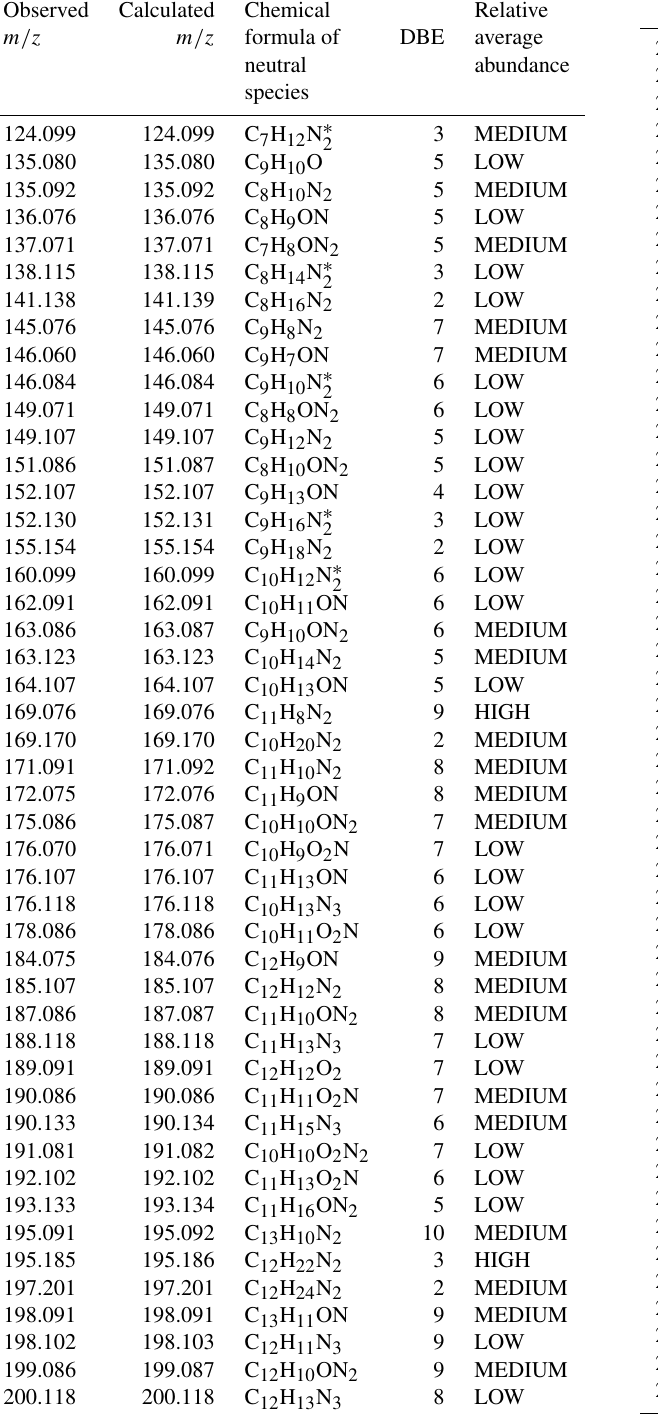
Table 2. List of compounds found exclusively in the emissions from dung cook fires, regardless of stove type. The labels for the peak abundances are the same as in Table 1. All species were detected as protonated ions unless otherwise